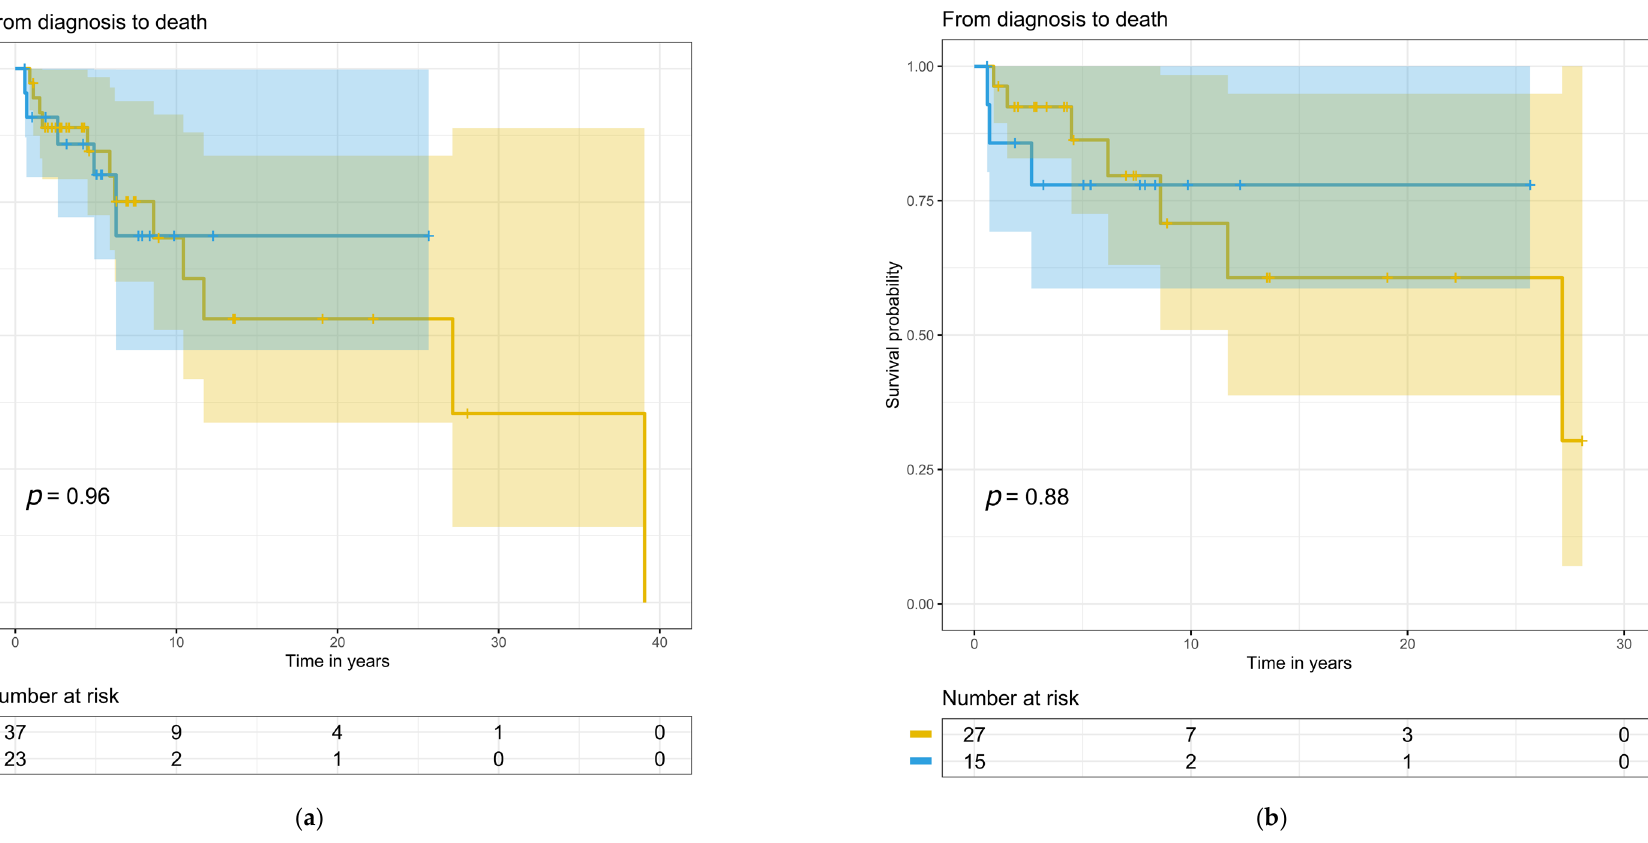
Figure 6. Longitudinal changes from diagnosis to death with numbers at risk: ( a ) for the entire study population; ( b ) for primary MPGN and C3G cases. The yellow line indicates IC-MPGN, and the blue line C3G. Colored areas indicate confidence interval and small vertical lines indicate the end of follow -up.